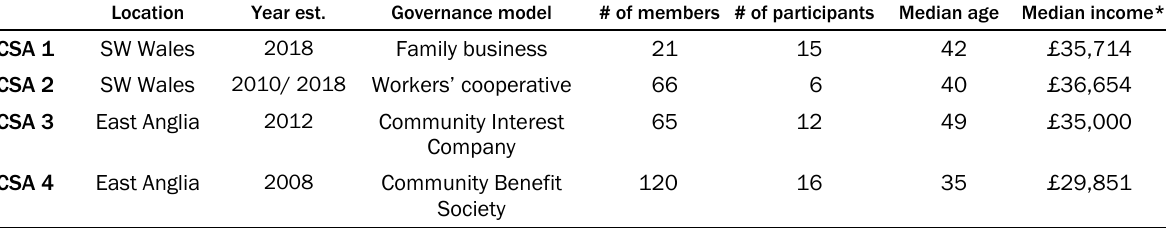
Table 1. Characteristics of CSAs Participating in the Research